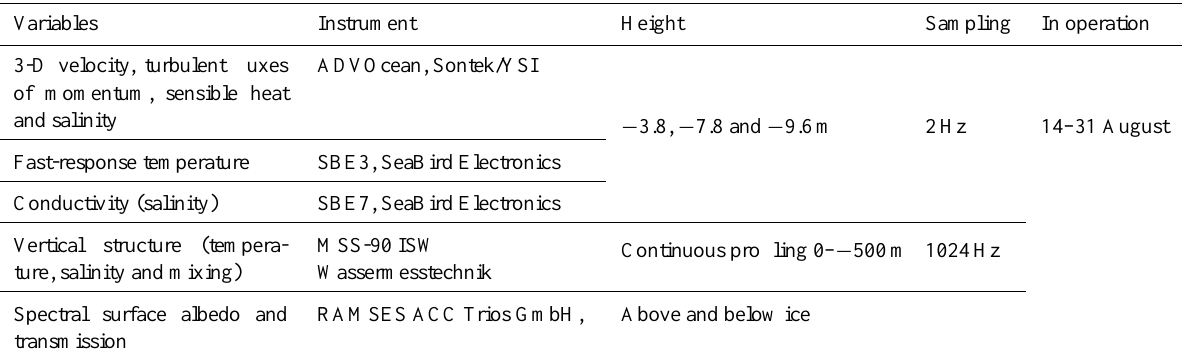
Table A9. Summary of the physical oceanography instruments at the “Met Alley”